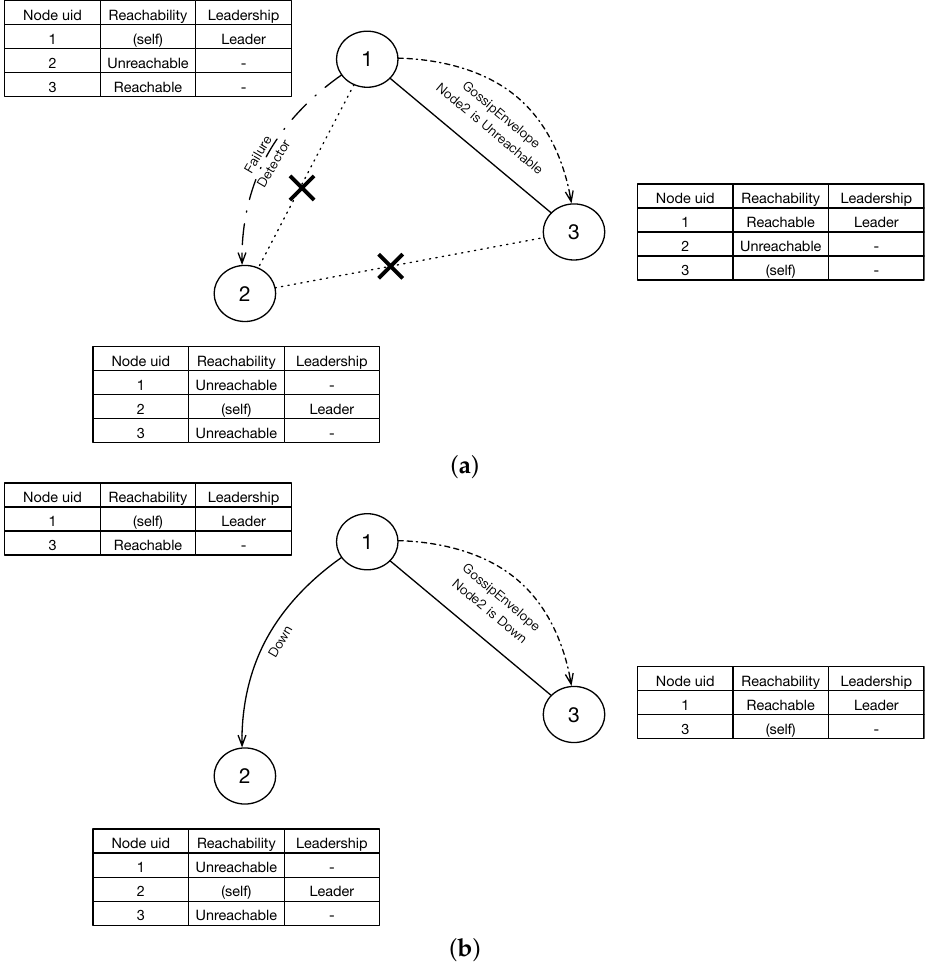
Figure 1. System overview of decentralized clusters that use gossip consensus protocol to manage members. ( a ) shows the member states, leadership and gossip process when detects a failure; ( b ) shows the down process of a